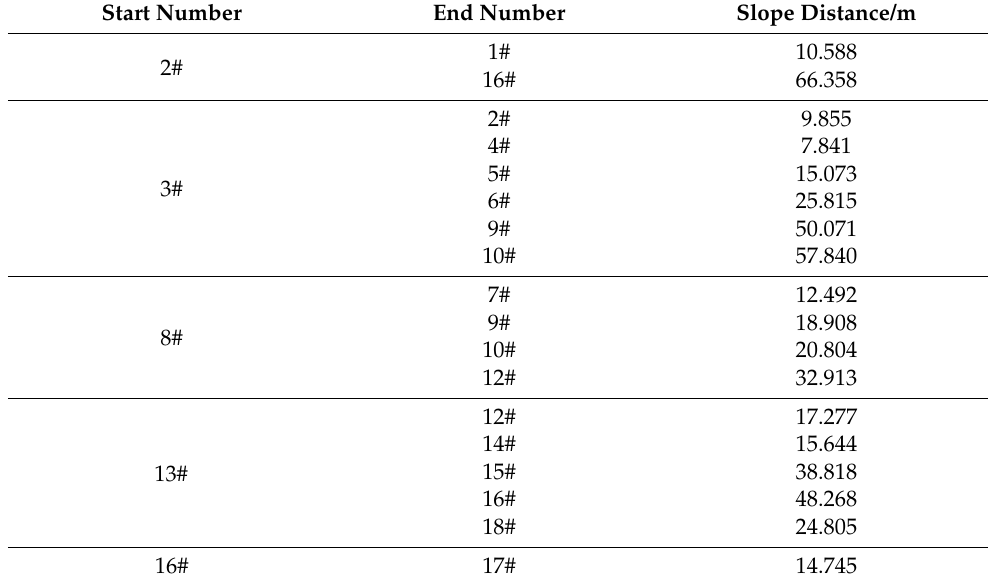
Table 4. True distances between targets.